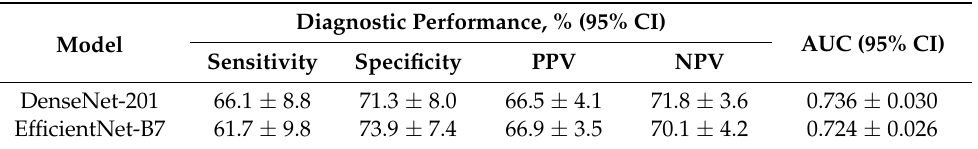
Figure 3. Confusion matrices of the best-performing folds of ( A ) DenseNet-201 and ( B ) EfficientNet-B7 for the prediction of the presence of white matter hyperintensity. Table 2. Diagnostic performance of deep learning models predicting the presence of white matter hyperintensity.